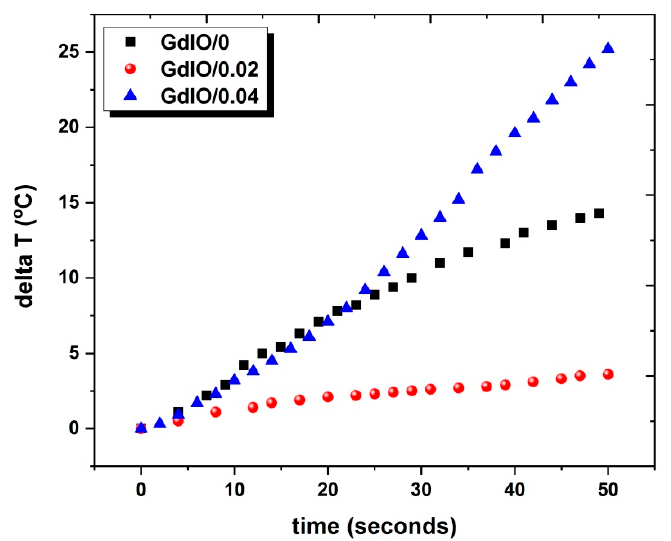
Figure 10. Temperature rise versus time for the three samples: Gd IO/0, Gd IO/0.02 and Gd IO/0.04. The highest obtained value of SAR is 97.0 W/g for Gd IO/0.04 followed by 67.4 W/g for Gd IO/0 and finally, 16.64 W/g for Gd IO/0.02. Thus, Gd IO/0.04 gave almost a sixfold